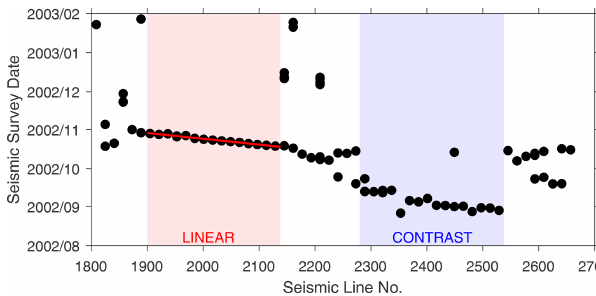
Figure 4. Dates of the seismic survey for the survey lines analyzed in our work. Two highlighted periods are a linear acquisition pe- riod (lines #1900–2140) during which data were collected linearly in time and space intervals, and a contrast acquisition period (lines #2280–2540), which can display a huge time jump in seismic im- age. The line number here is equivalent to the inline number at the center of a seismic